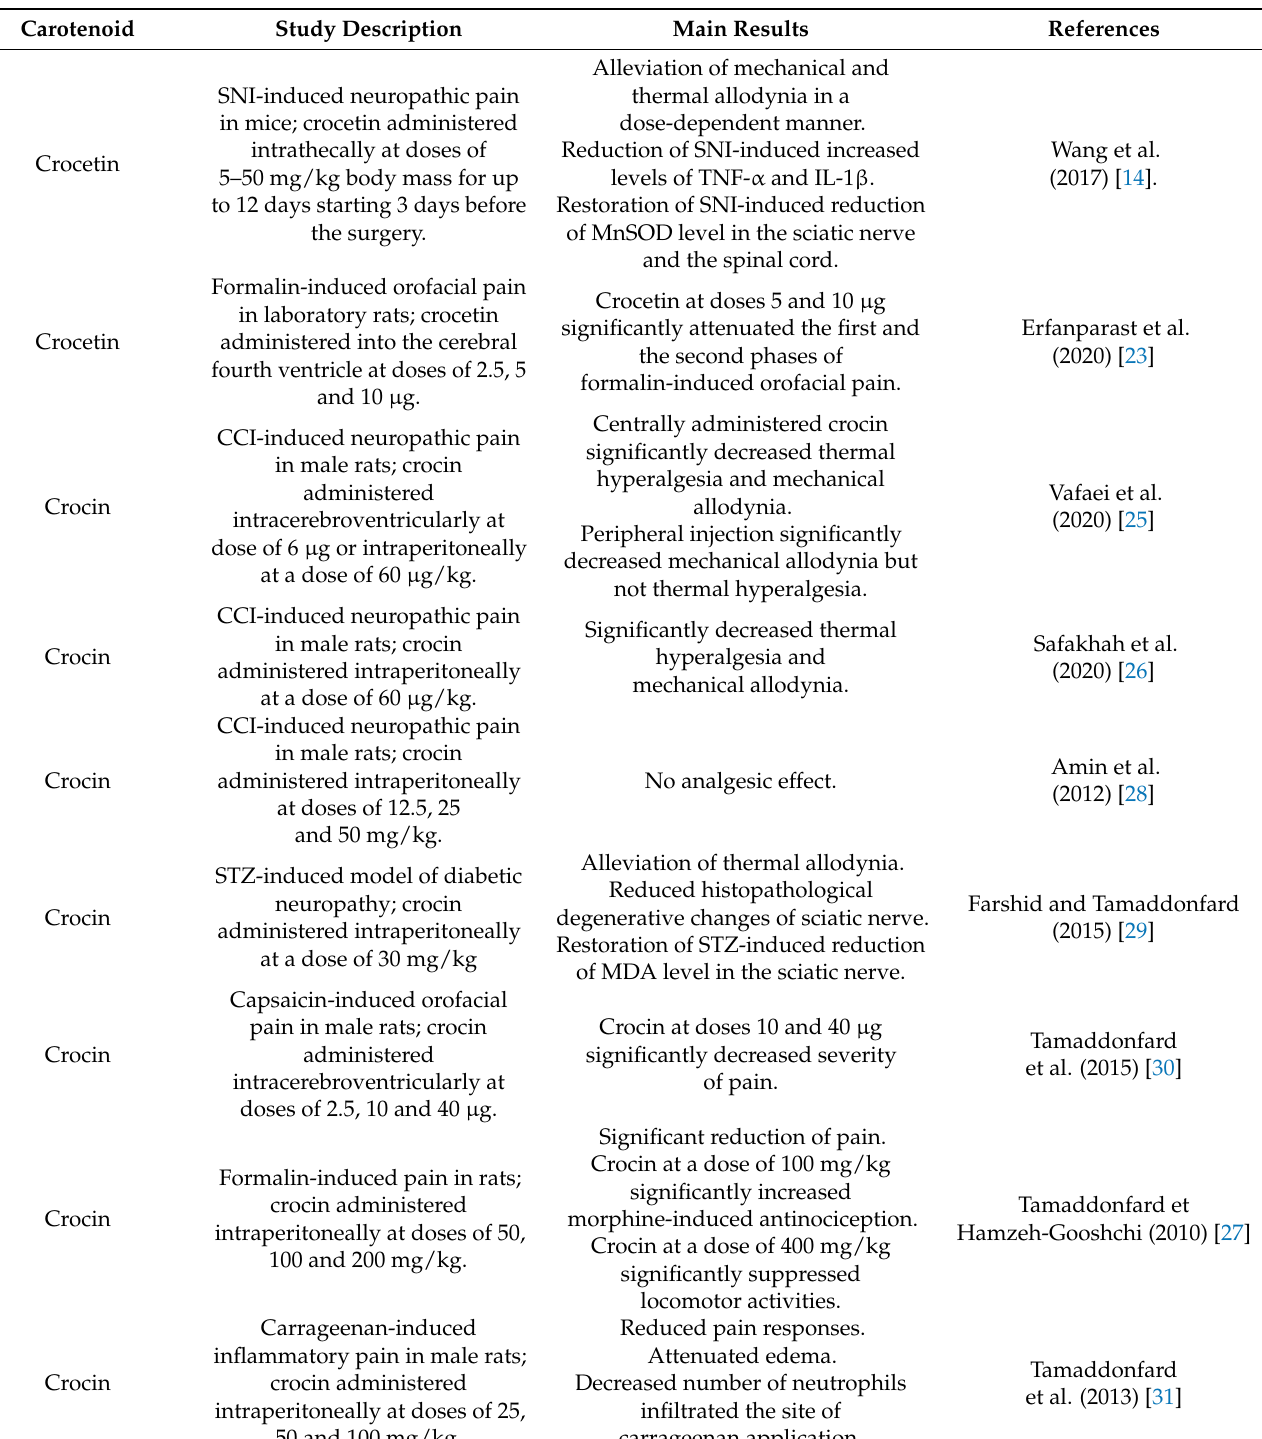
Table 1. Preclinical studies on the antinociceptive effect of carotenoids on animal models of neuro- pathic